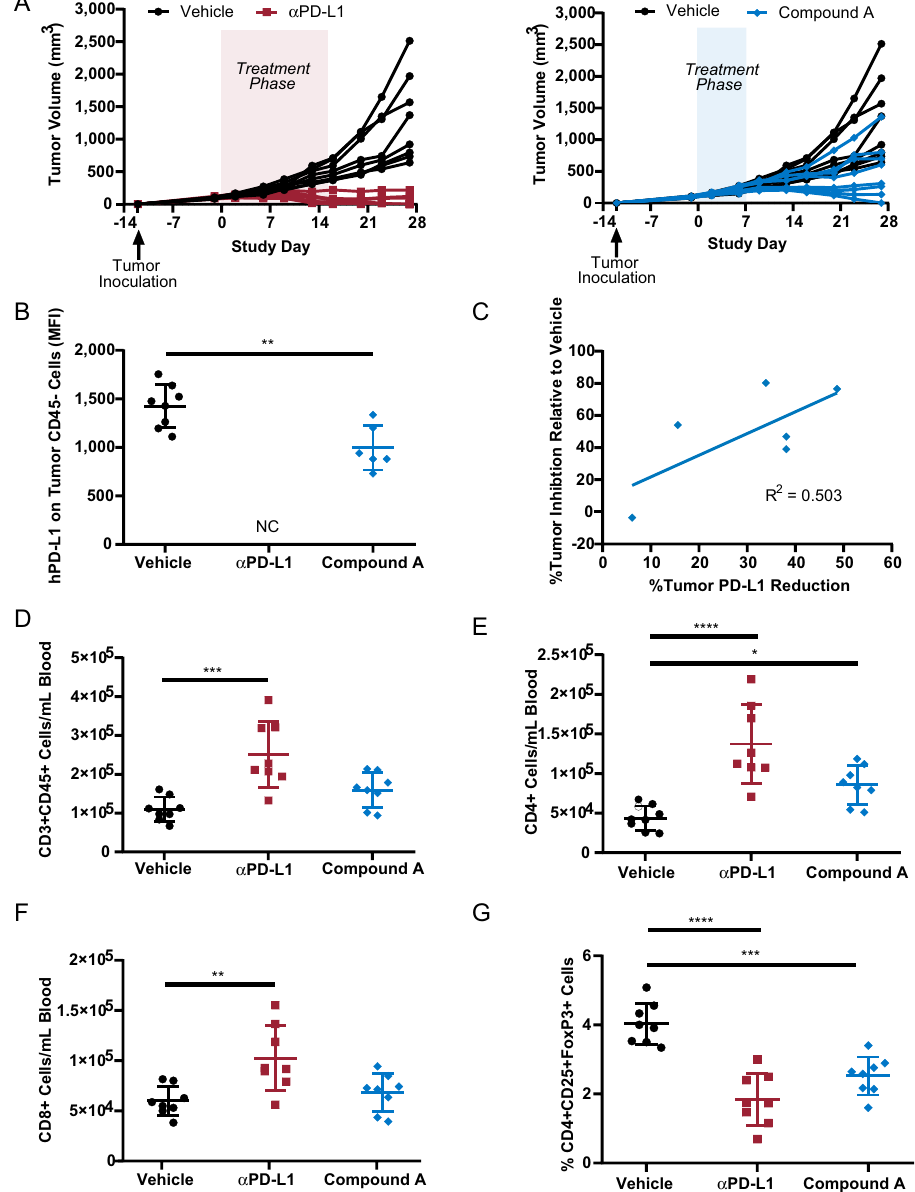
Fig. 3 PD-L1 targeting in mouse model for colorectal cancer. a Tumor growth of PD-1/PD-L1 humanized mice implanted with MC38 cells expressing humanized PD-L1 and treated with compound A (10 mg/kg orally for seven daily doses days 0 – 6), or α PD-L1 (10 mg/kg intraperitoneal injection thrice weekly days 0 – 16). Statistically signi fi cant tumor growth inhibition was observed with α PD-L1 antibody or compound A treatment ( p < 0.0001 or p = 0.009, respectively, group means comparison relative to vehicle by one-way ANOVA with Dunnett ’ s multiple comparisons test). b Compound A treatment mediates decrease in tumor PD-L1 expression at day 28. ** p = 0.002 by unpaired t test. NC data not collected due to insuf fi cient tumor amounts for analysis. c Tumor inhibition is directly correlated with the degree of tumor PD-L1 reduction. d – f Counts of CD3 + cells in blood at day 28, with further gating for CD4 + or CD8 + cells. g Frequency of T regulatory cells in blood. * p = 0.03, ** p = 0.003, *** p = 0.0002, **** p < 0.0001 by one-Way ANOVA with Dunnett ’ s multiple comparisons test. Source data are provided as a Source data fi